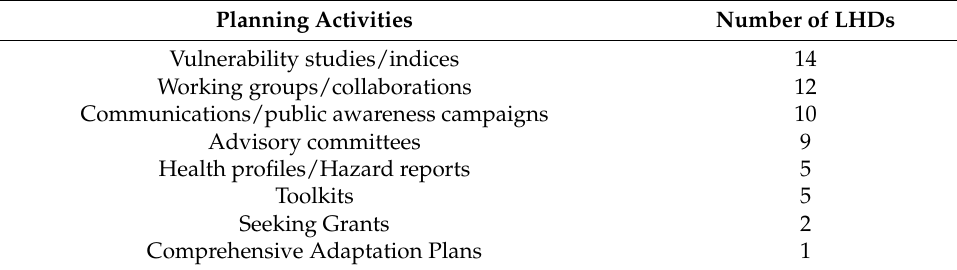
Table 2. Planning activities used by 14 LHDs to respond to climate